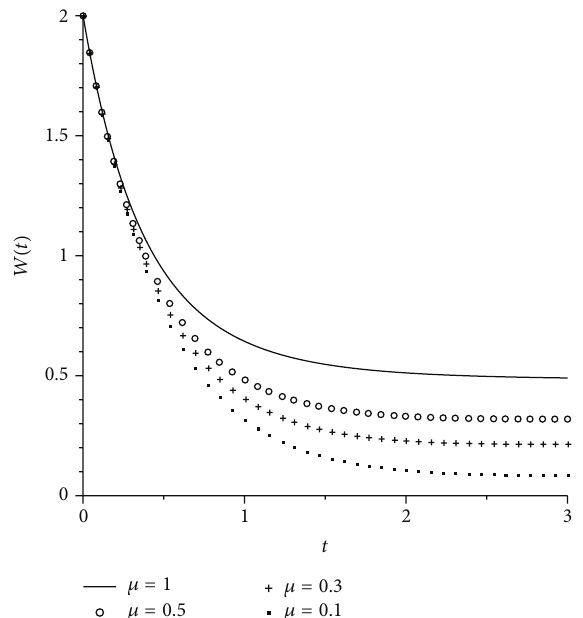
Figure6:Instantaneousfailurefrequenciesofthesystemwithwarn- ing device with different 𝛼 0 .